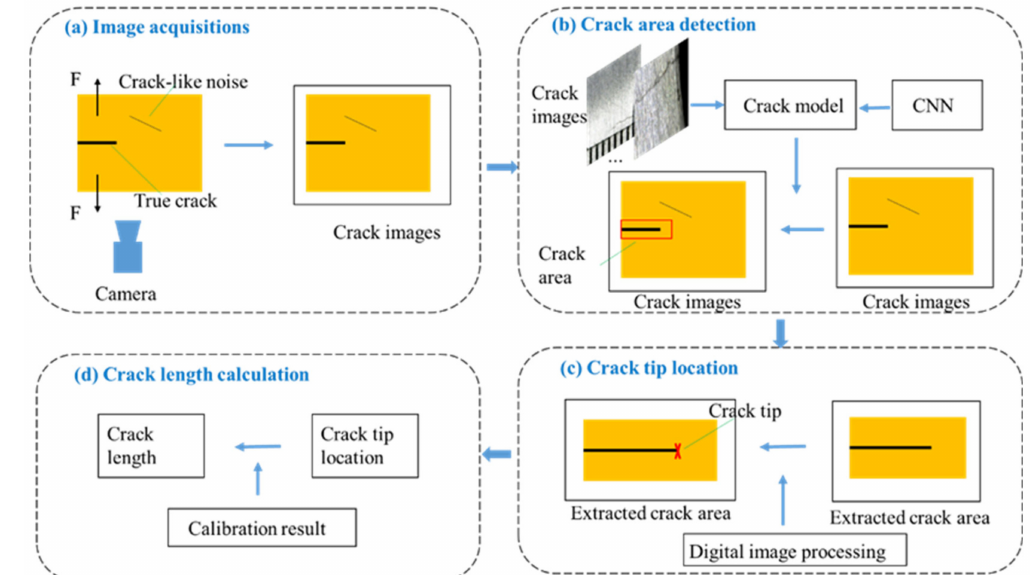
Figure 1. The scheme of the crack length measurement method: ( a ) image acquisitions; ( b ) crack area detection; ( c ) crack tip location; ( d ) crack length